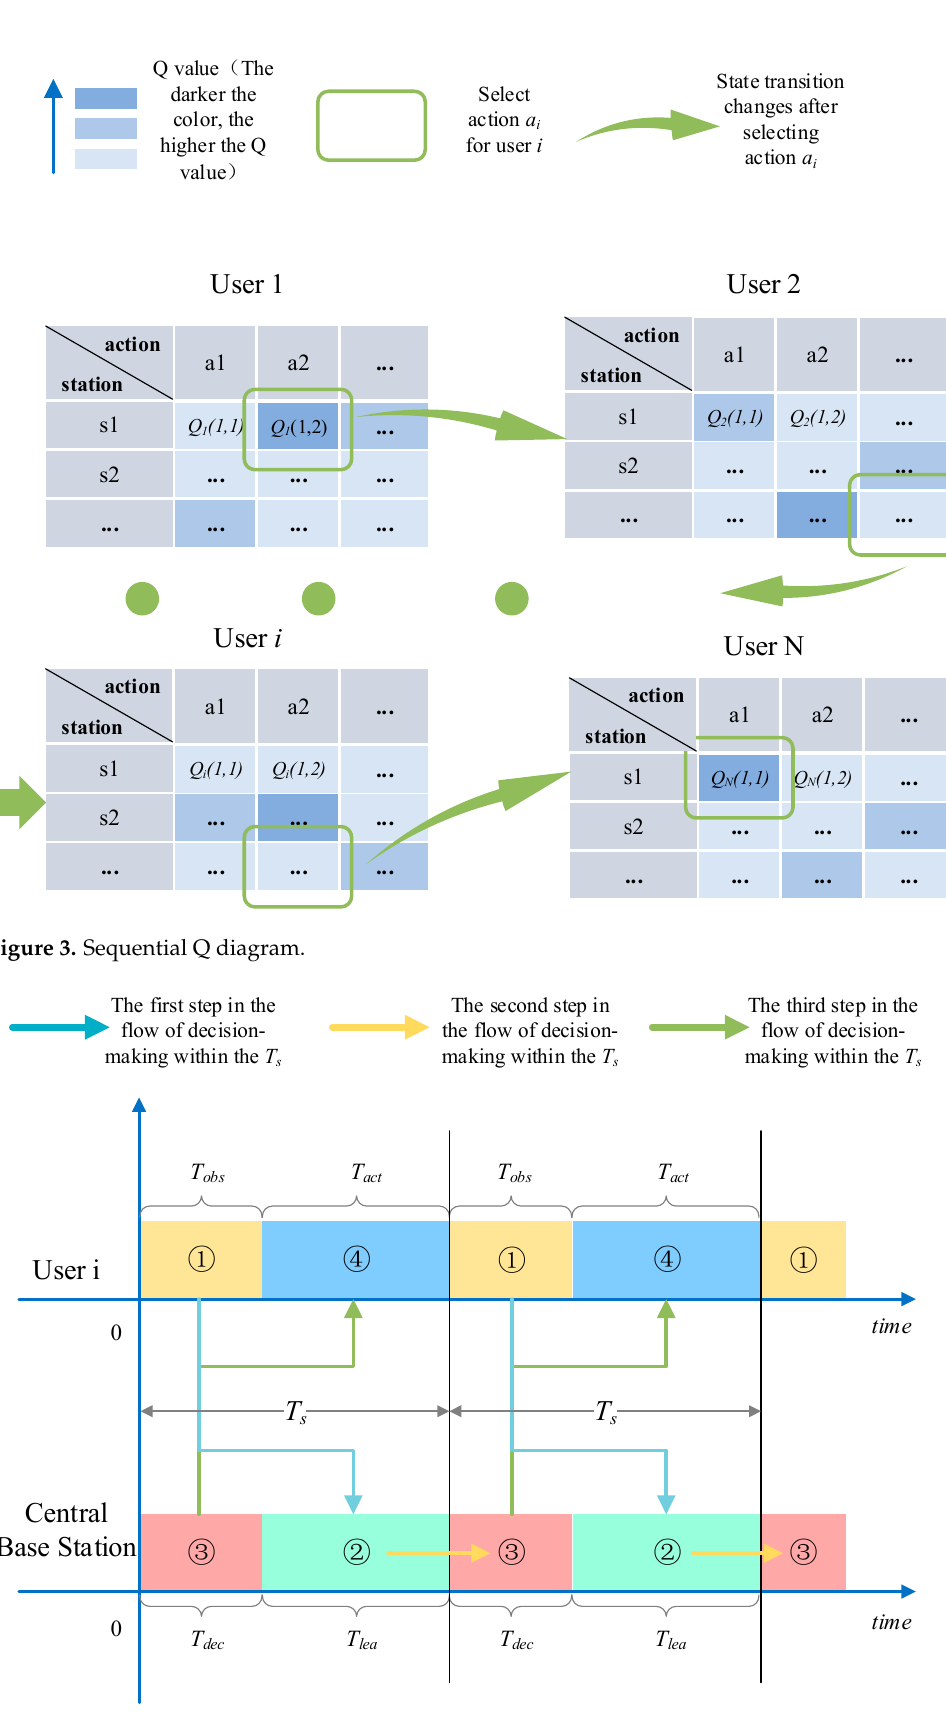
Figure 4. Schematic diagram of decision flow in a time slo t.